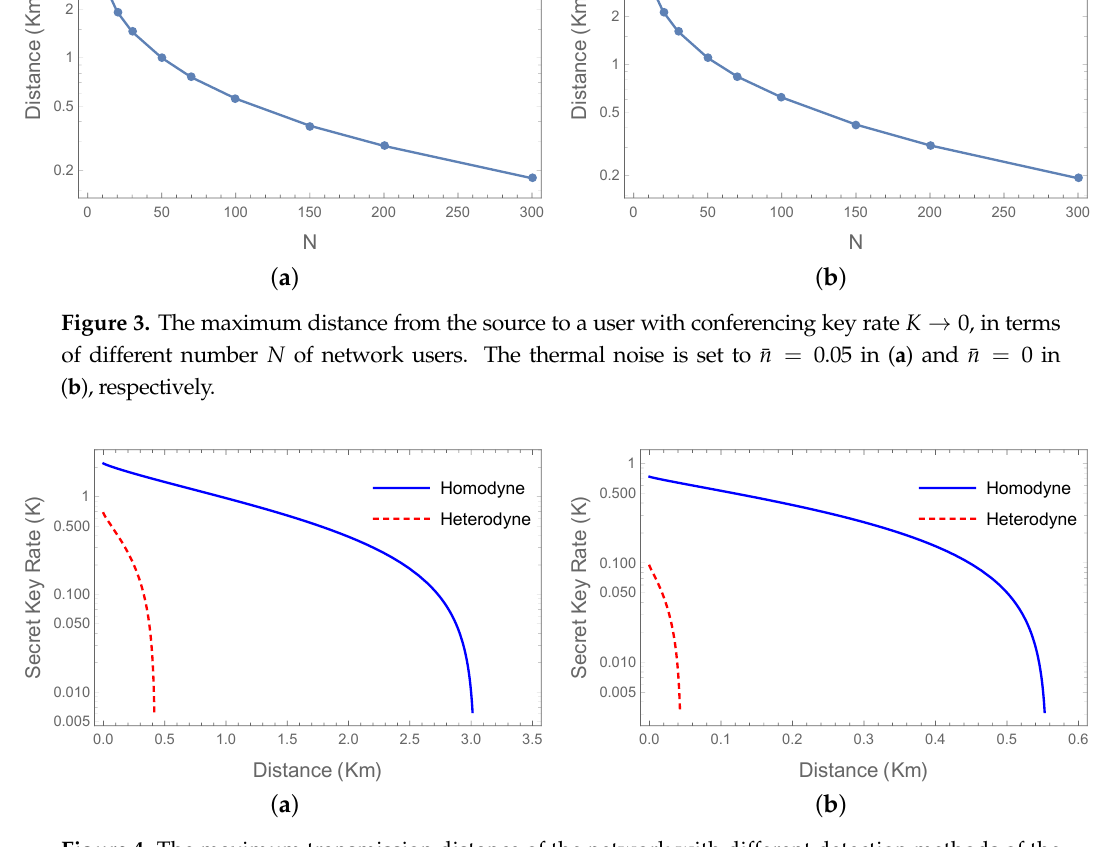
Figure 4. The maximum transmission distance of the network with different detection methods of the users. The number of users is set to 10 in ( a ) and 100 in ( b ), respectively. The blue solid (red dashed) lines show the conferencing key rate when all the users perform homodyne (heterodyne) detection on their received